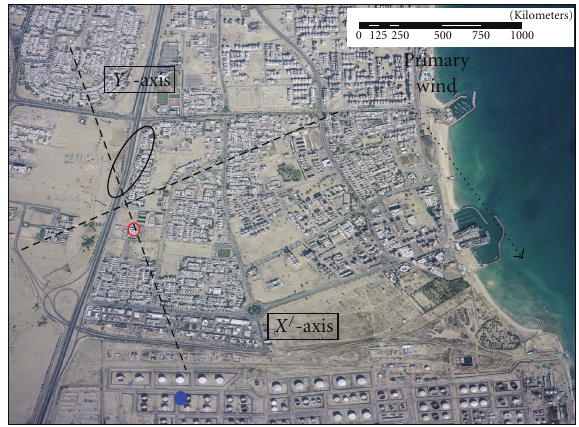
Figure 4: Imaginary axis lines for point source modelling around Fahaheel highway showing corresponding coordinates at: X = 14.5 cm and Y = 2.1cm. The blue dot represents the source at the refinery (Tank farm) and the red and black circles represent, respectively, the receptor point and the point of calculation for the line